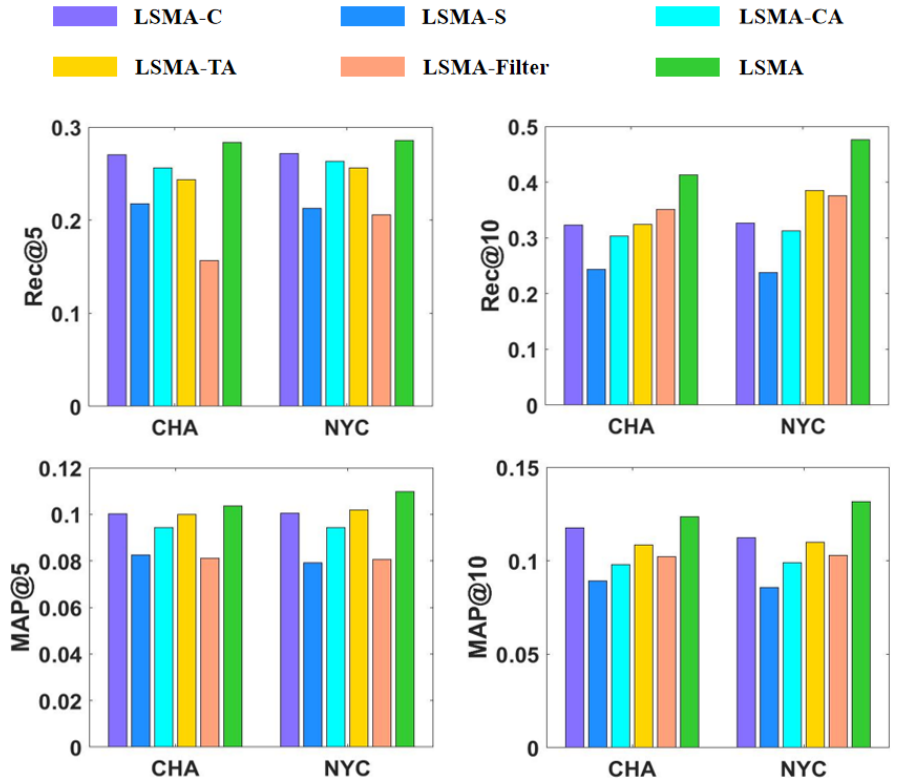
Figure 7. Performance comparison of LSMA and its variants on the CHA and NYC